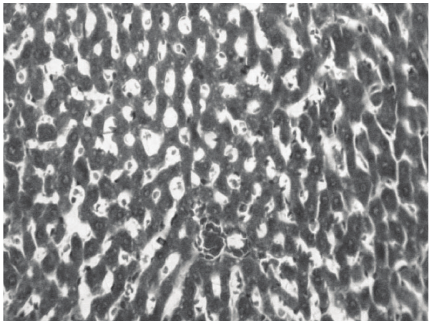
Figure 4: Liver section in TCA- and AOLE-treated rats showing a moderate improvement in hepatocellular structure, evidenced as a moderate improvement in vacuolation and compactness of hepatocytes compared to TCA-treated group but dilated sinusoids are still